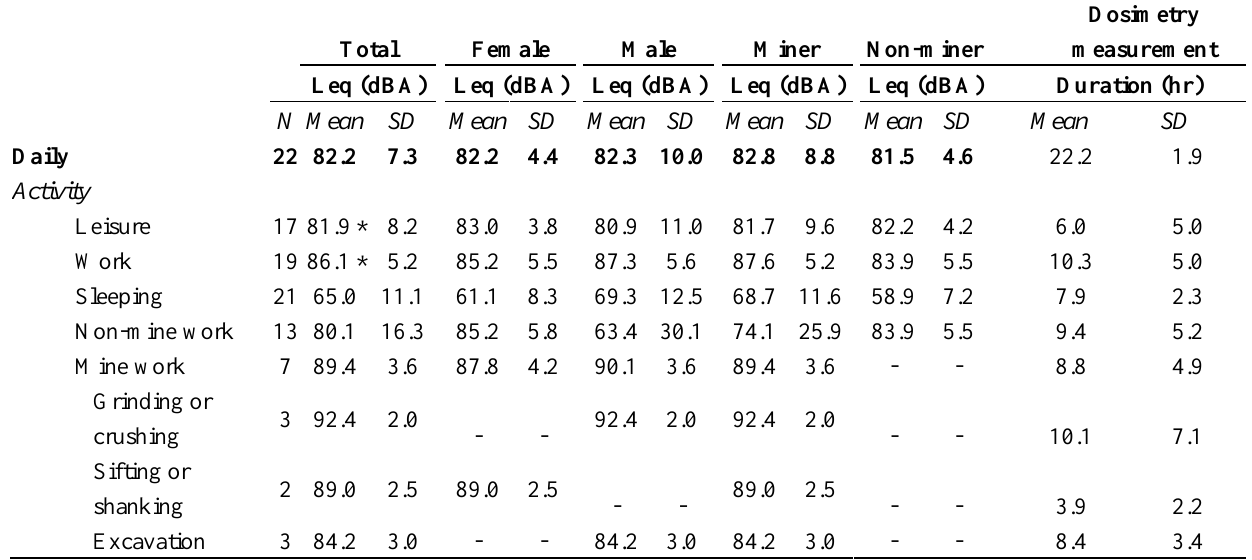
Table 2. Summary of personal noise exposures over sampling period.